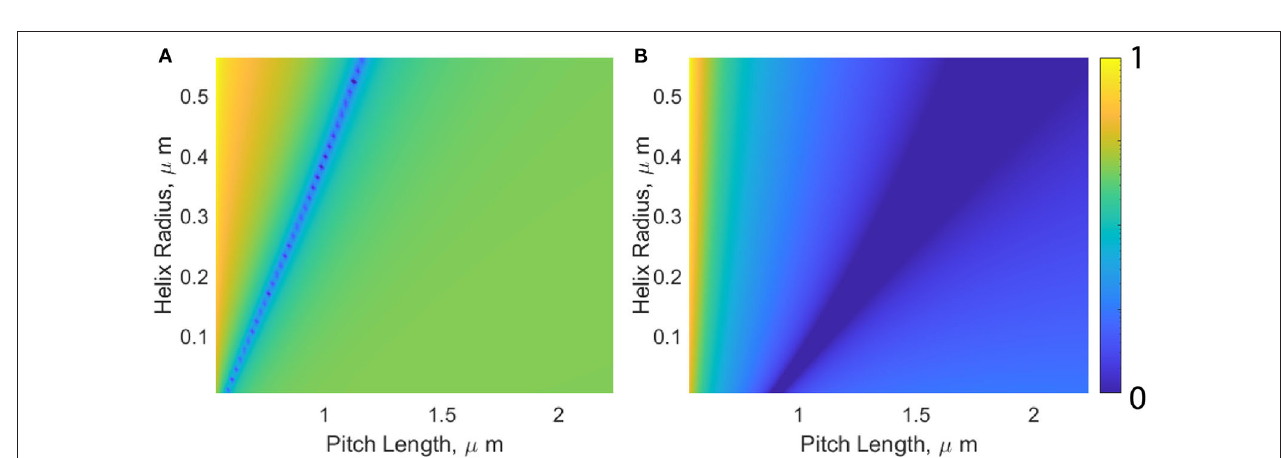
FIGURE 3 | (A) Change in flagellum rotation rate, as predicted by RFT and mRFT, using parameters from Table 1 . (B) Measured swimming forces ( F = B ω RFT / mRFT )with increasing viscosity. Experimental measurements are compared to propulsive force predictions made by RFT and mRFT. Error bars show one standard deviation of force measurements.